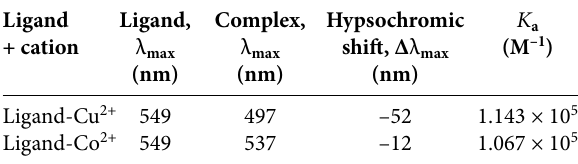
Table 3: UV-vis spectra data upon titration of compound 2 with cations in DMSO